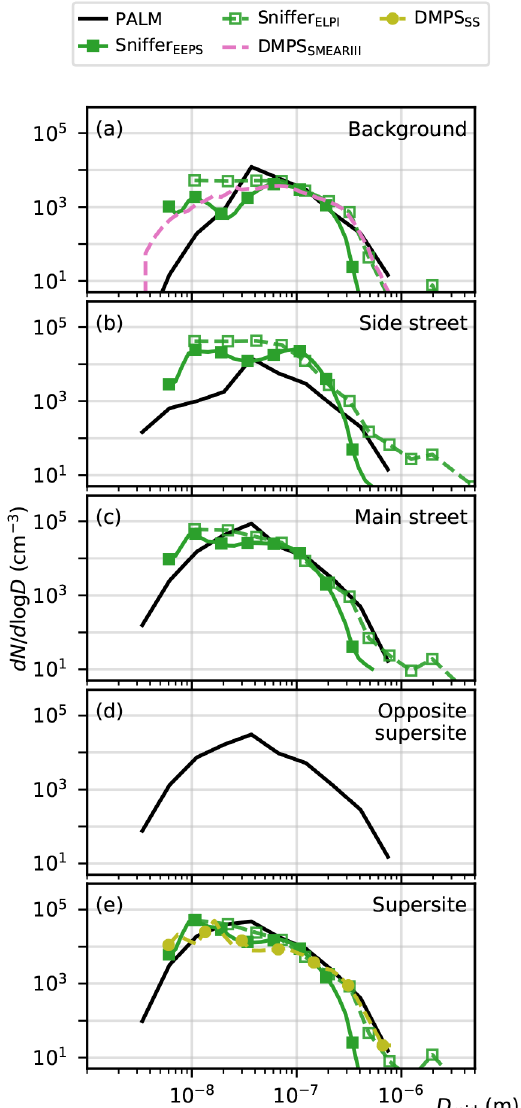
Figure 10. The mean aerosol number size distribution d N/ dlog D (cm − 3 ) at different parts of the domain at z = 1 . 5m for M MET M PSD on the morning of 9 June at 07:16–08:14LT. Mod- elled values are shown with a solid black line and Sniffer measure- ments with green lines: solid with filled squares for EEPS and dot- ted with empty squares for ELPI. Stationary DMPS measurements are shown with a solid light-green line with circles (SS indicates a supersite) and dotted pink line (SMEAR III). Note that for this ob- servation period no stationary Sniffer measurements are available opposite the supersite.